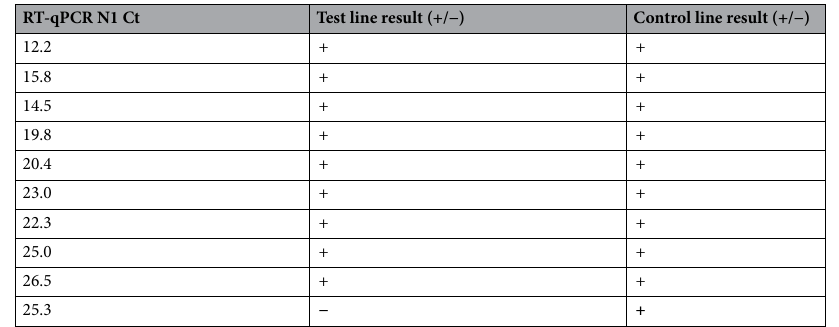
Table 4. Visual interpretation summary of test kit-based study. 400 µL of RT-qPCR known positive SARS- CoV-2 saline swab samples added to sample extraction buffer tube and evaluated on SARS-CoV-2 antigen RDT. The results agree with previous cutoff for RT-qPCR positives on RDT around 25 Ct for the N1 assay.